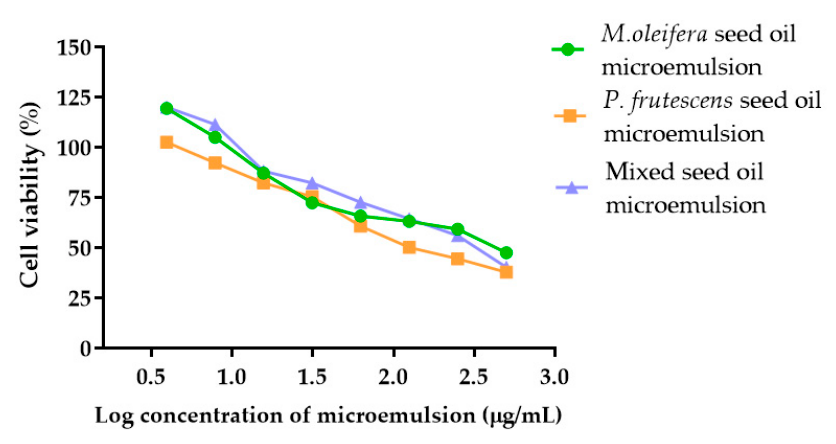
Figure 5. Cell viability percentage of PBMC in the presence of P. frutescens, M. oleifera , and mixed seed oil microemulsions at various concentrations. Data represent mean ± SD from three experi- ments.